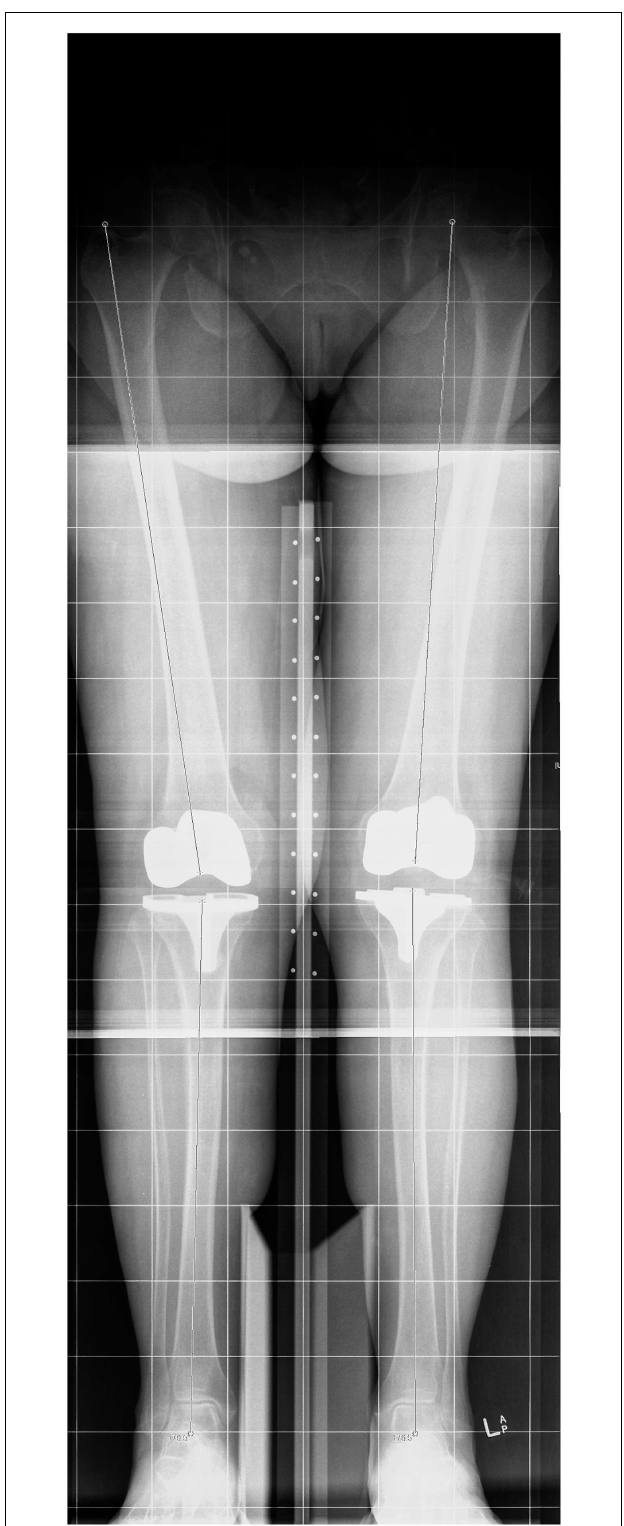
FIGURE 3 | Measurement of mechanical and anatomical axes on the long-leg X-ray